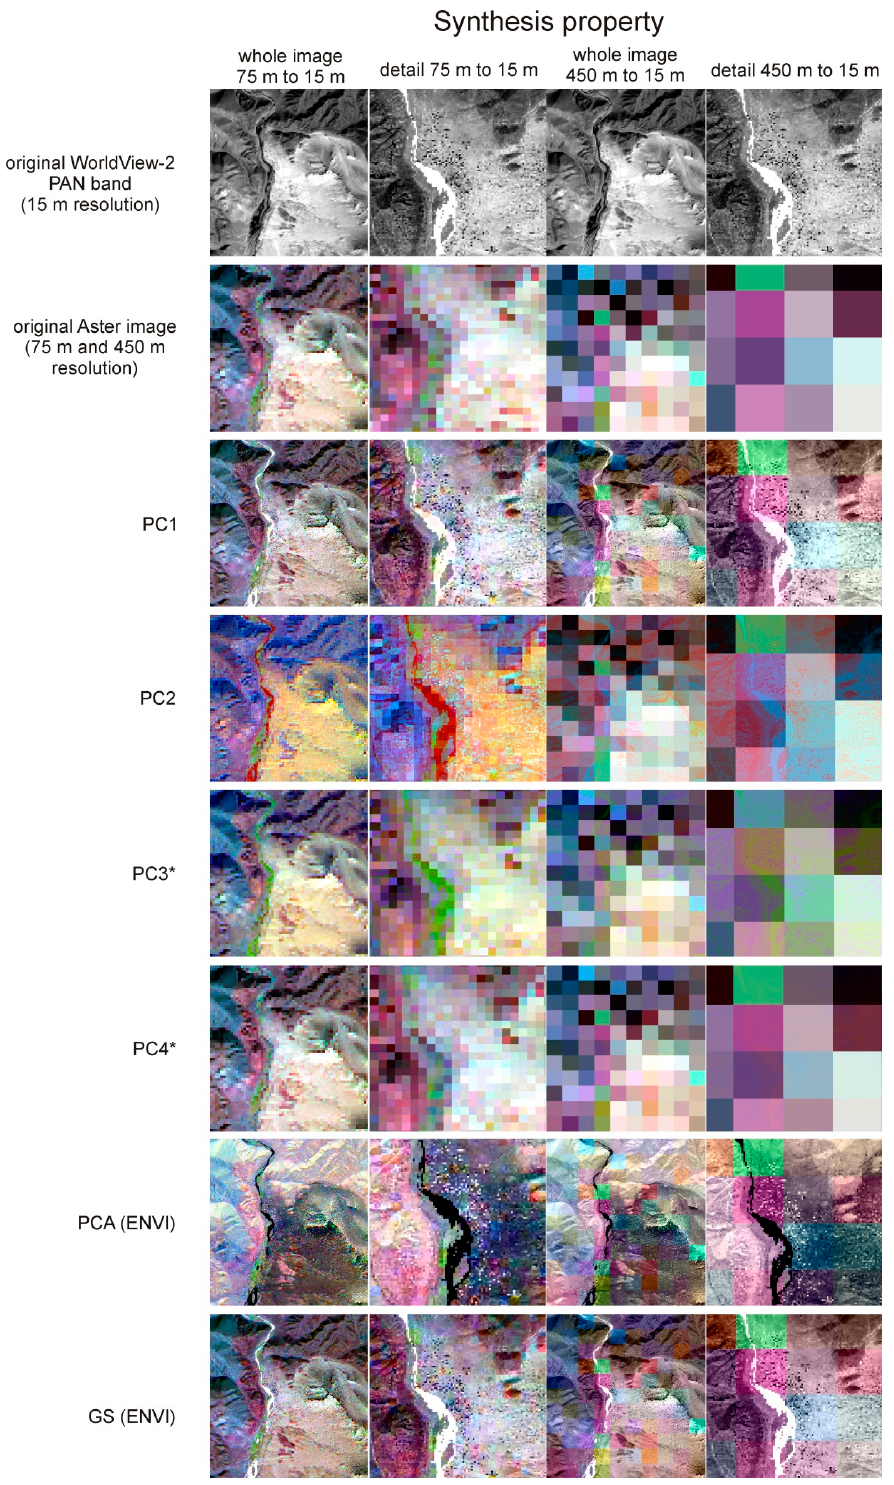
Figure 8. Synthesis property of fused ASTER images. Fusion was performed on the synthetic images, created so as to preserve the ratio between the spatial resolutions of the MUL and PAN, while the synthetic PAN image obtains the spatial resolution of the original MUL and synthetic MUL and is therefore resampled to 75-m and 450-m, respectively. It was expected that the first two PCs have the potential to give good results when employing the PCA sharpening process, however PC3* and PC4* were used to compare the result and explain it in a wider context.